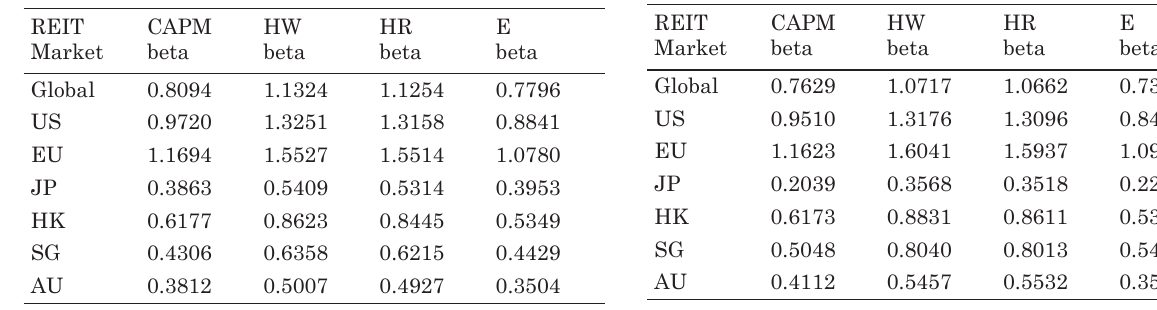
Table 7. The mean of time-varying conditional